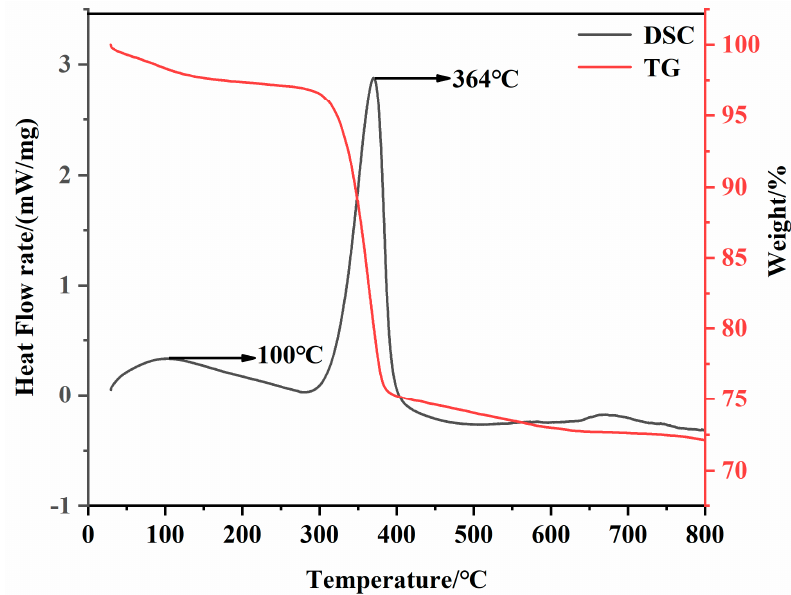
Figure 4. TG-DSC of magnesium residue before calcination.